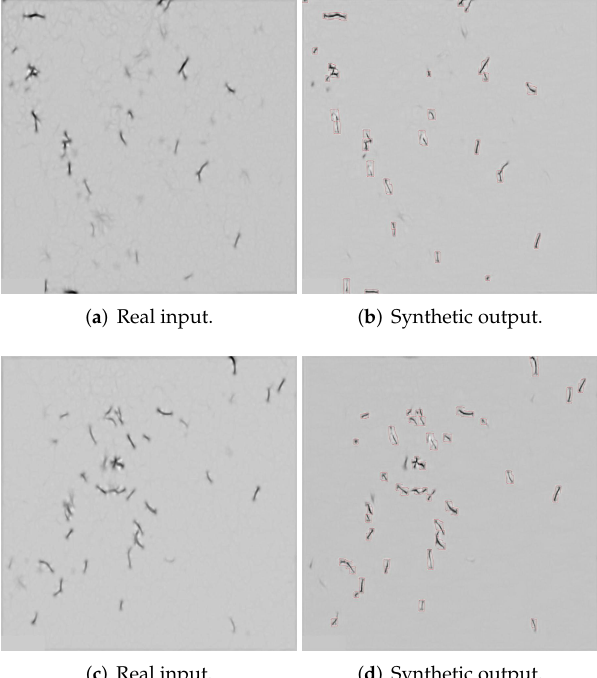
Figure 4. Examples of ( a , c ) complex and cluttered original input images and ( b , d ) the corresponding output images generated using the proposed cycle-GAN, showing synthetically superimposed bounding boxes around the bacterial content of